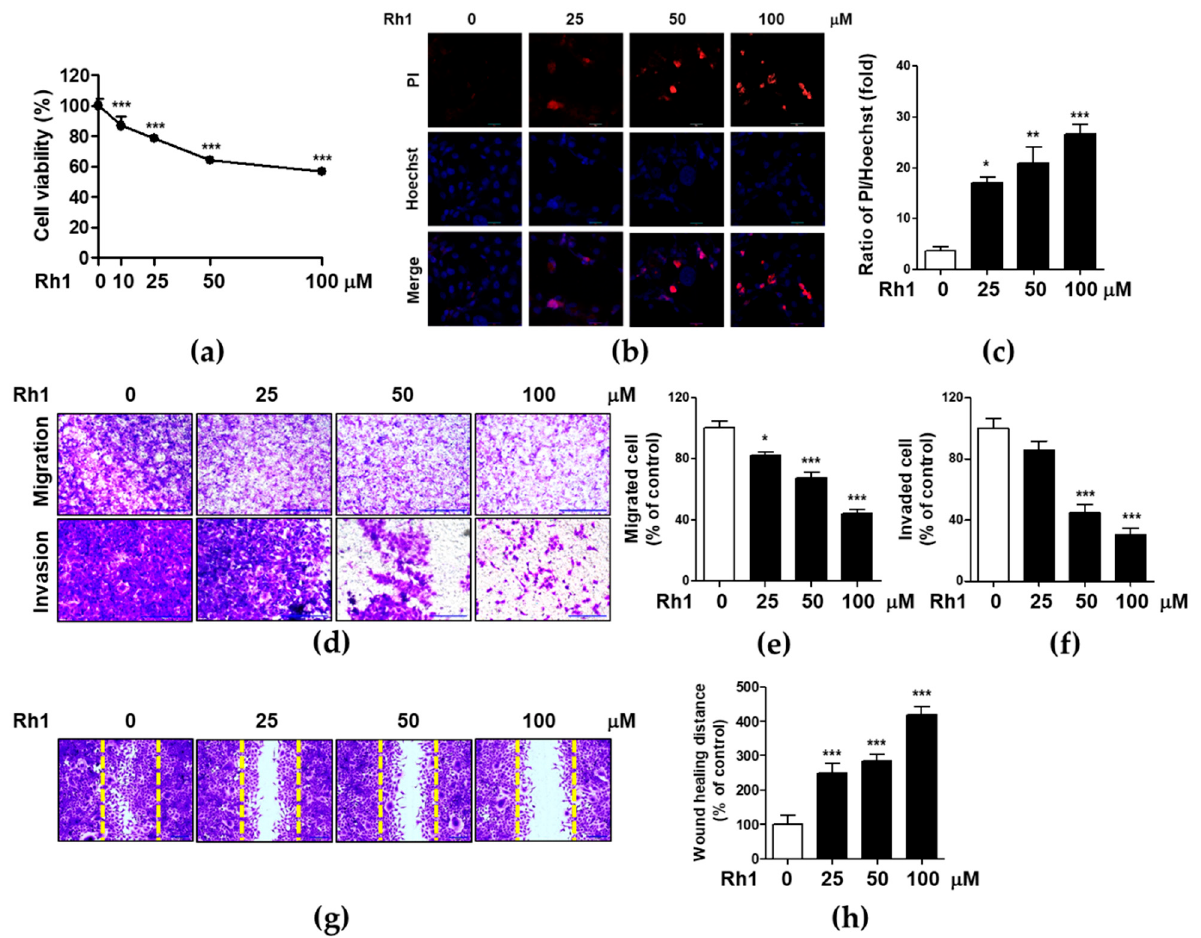
Figure 1. Rh1 inhibited cell viability, migration, and invasion in MDA-MB-231 cells ( a ) MDA-MB-231 cells were treated with indicated concentrations of Rh1 for 24 h. Cell viability was evaluated by MTT assay. ( b , c ) MDA-MB-231 cells were treated with Rh1 for 24 h. After dual stained with Hoechst 33324 and propidium iodide (PI), the cells were observed under a fluorescence microscope, and the numbers of dead cells were quantified. The cells stained with PI (red fluorescence) were indicated as dead cells. The scale bar indicates 30 μ m. ( d ) Images indicating the migration (upper) and invasion (bottom) of MDA-MB-231 cells through polycarbonate membrane. The bar indicates 200 μ m. ( e , f ) The number of cells were counted and shown in the column graph of the corresponding pictures. ( g ) After treatment with Rh1 for 36 h, cells were fixed, stained with crystal violets, and photographed using an Olympus microscope. The scale bar indicates 200 μ m. ( h ) The migration area was measured using image J software and indicated as fold change compared to the control (0) sample. The data are presented as means ± SEM ( n = 3). * p < 0.05, ** p < 0.01 or *** p < 0.001 compared with no treatment condition.